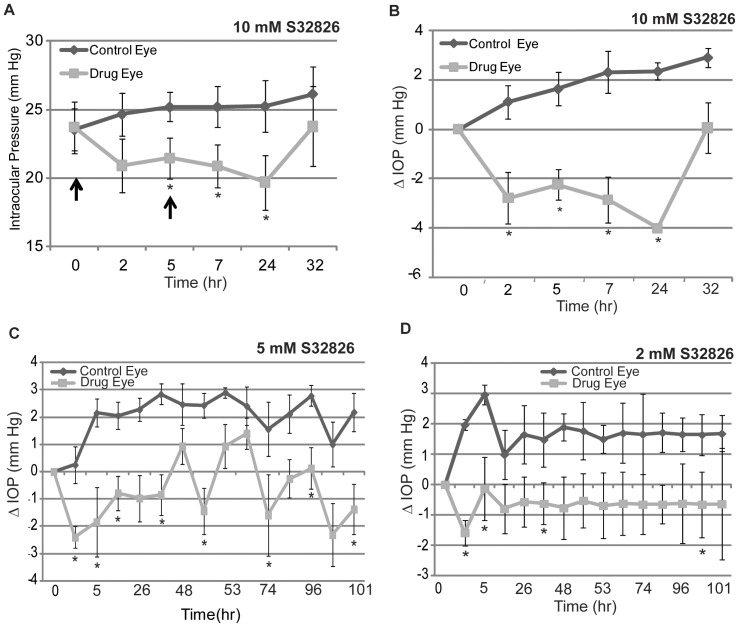
Topical application of ATX inhibitor (S32826) decreases IOP in rabbits.Topical application of S32826 (dissolved in water, pH∼8–9) decreased IOP in a dose- and time- dependent manner in Dutch-Belted adult male rabbits, as determined using pneumotonometer under waking conditions. A. 10 mM S32826 exhibited the maximum and statistically significant effect in lowering IOP (by 5–6 mm Hg; n = 9) with drug application at 0 and 5 hrs (indicated with arrows, 35 µl×2) relative to sham controls receiving pH adjusted water. The IOP-lowering effect of drug lasted for a minimum of 24 hrs, after which, the changes in IOP began to normalize and were similar to control values by 48 hrs after initial drug application. B. The effects of S32826 (10 mM) on net change in IOP from basal values in the same animals. Net IOP values were significantly reduced from basal values, and between 2 to 24 hours following drug administration, based on a paired t-test. Further, IOP in the drug treated eyes was significantly reduced as compared to IOP in the control eyes based on the Wilcoxon Rank Sum test of differences in median's (n = 9). C and D. Effects of 5 and 2 mM S32826 on IOP with a daily (single morning dose, 35 µl×2; n = 4) dose of drug application, respectively. Relative to the 2 mM concentration of drug, administration of 5 mM drug resulted in a significant drop in IOP starting from 2 hrs post drug injection as compared the control values, with the IOP lowering effect lasting till the end of the study (5 days later). While eyes treated with 2 mM S32826 exhibited IOP values that were significantly reduced relative to control values throughout the 5-day study period, based on the Wilcoxon Rank Sum test of differences in medians, significance was not consistent across all time points as shown in the figure. In all these experiments, sham treatment alone increased IOP; the difference was not significant relative to the basal IOP values in any of the experiments. *P<0.05.